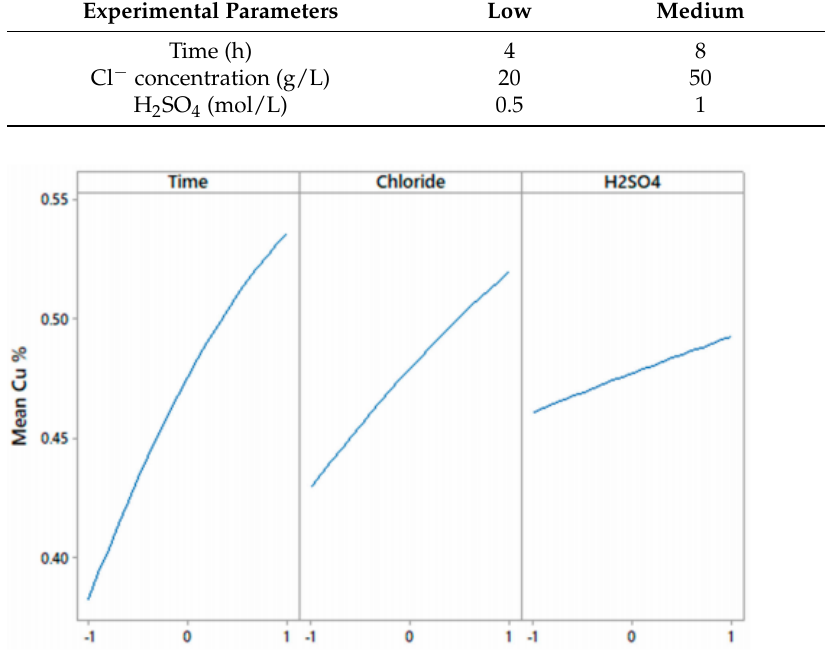
Figure 5. Linear effect graph for the extraction of Cu from chalcocite in a chloride medium [13].